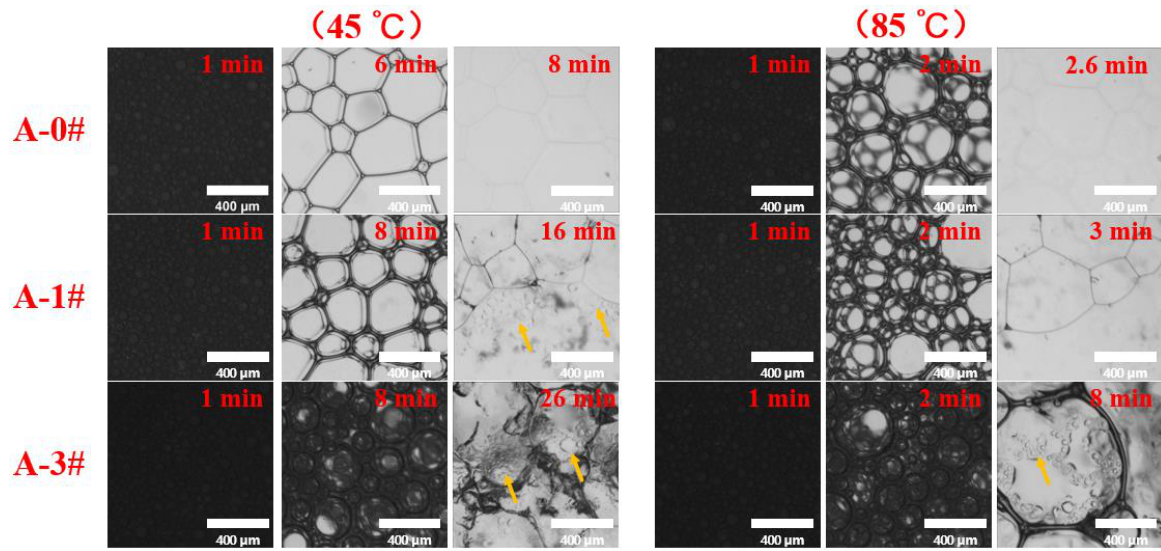
Figure 6. Morphology of bubbles during foam coarsening under thermal action.